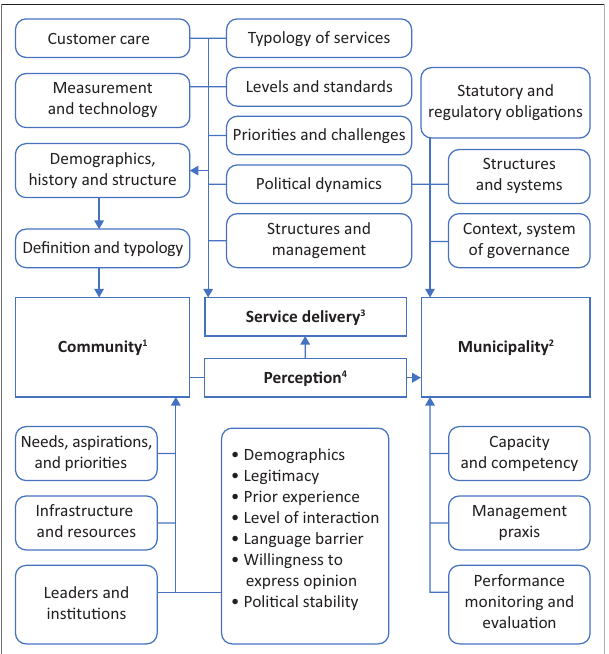
FIGURE 2: Example of a comprehensive conceptual